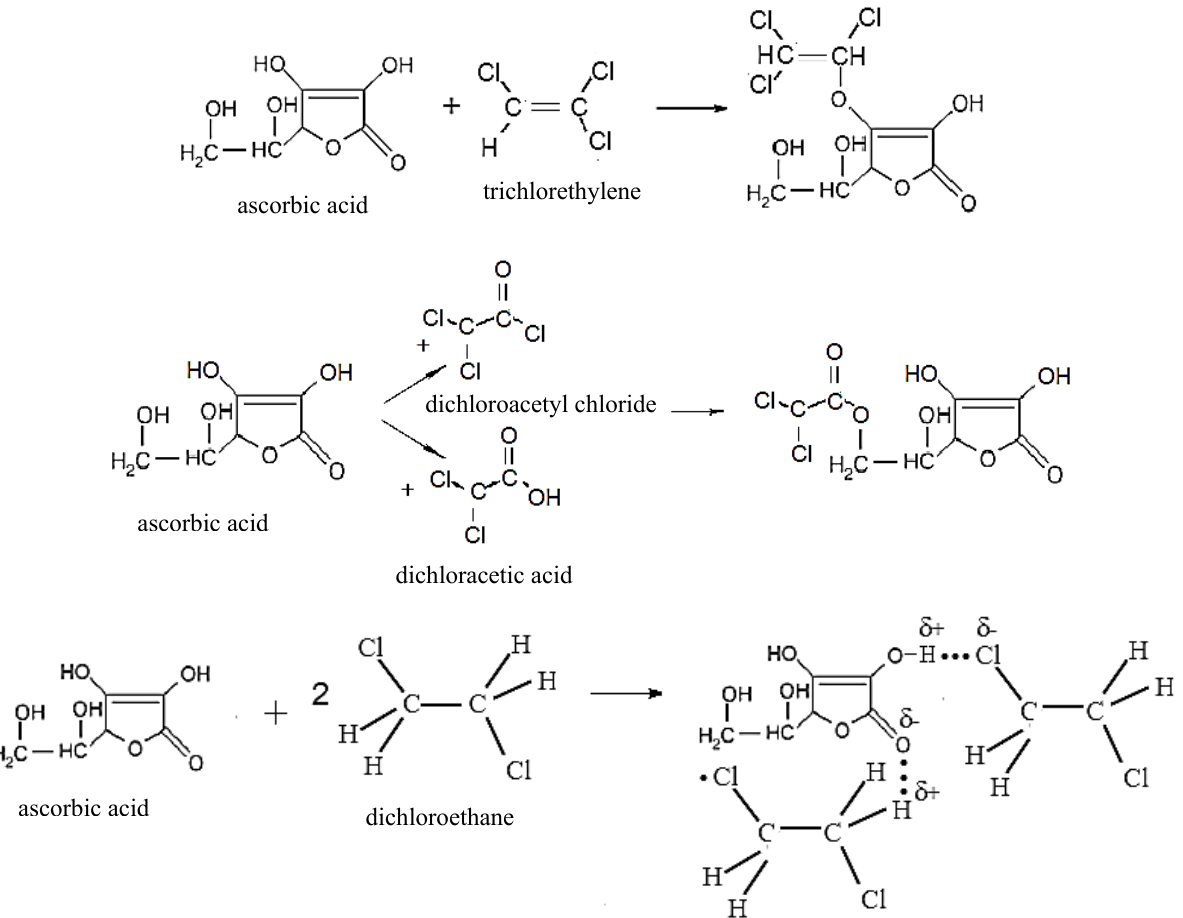
Fig. 17. Chemical interaction of vitamin C with the priority contaminants contained in